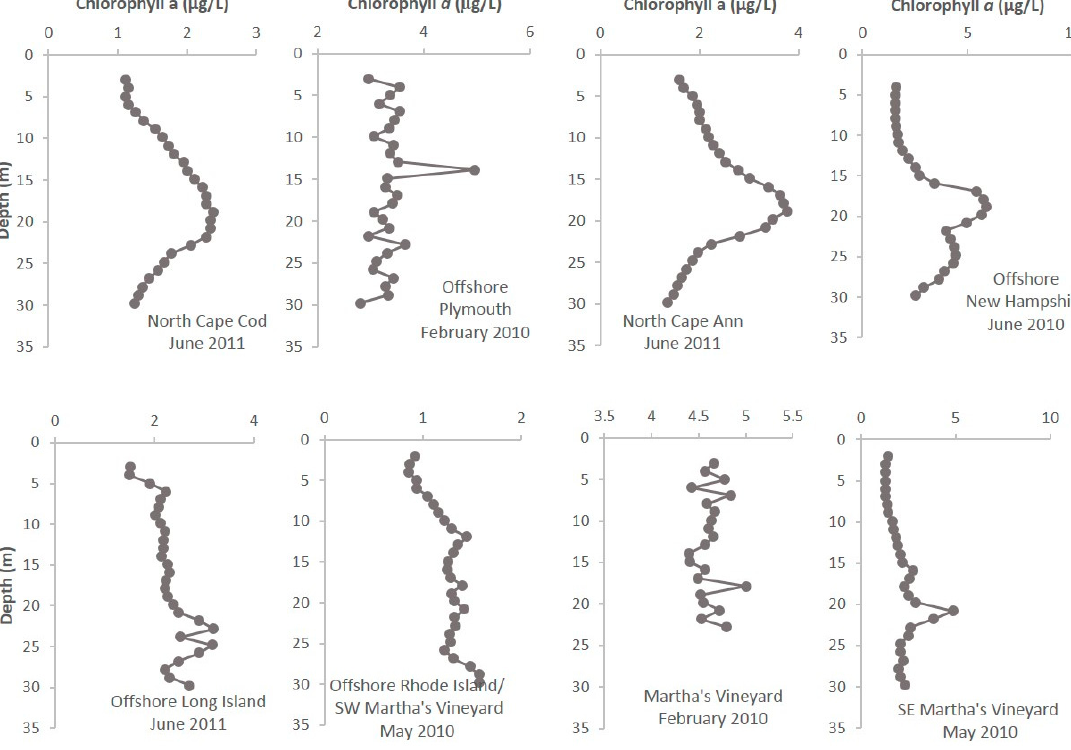
Figure 10. Vertical profiles of chlorophyll a at different regions along the northeast shelf during the years of 2010 and 2011, lined by region. Note the chlorophyll maximum position in the water column situated between 13-m and 30-m depth at all stations.